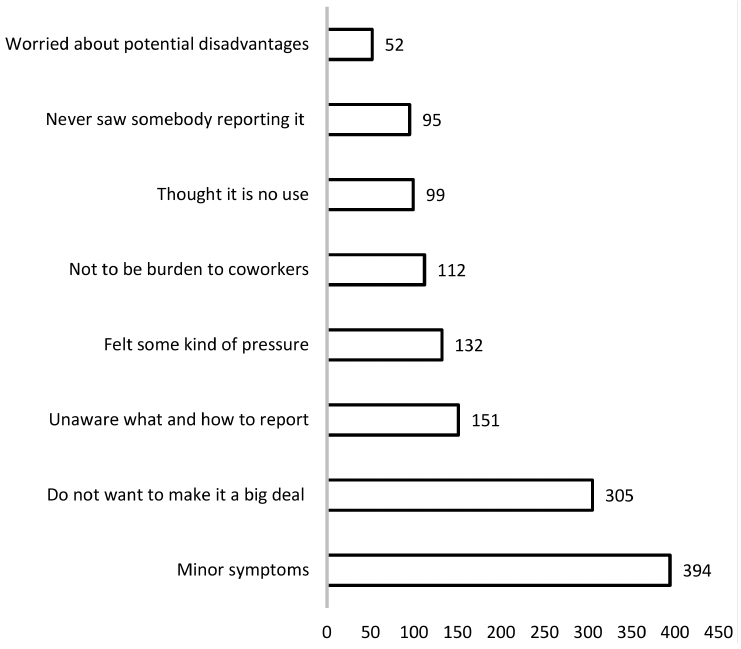
Figure 1. The reasons for not reporting WRMSD to the company (allowed multiple answers). Table 2. Frequency and prevalence (frequency/respondents) of musculoskeletal symptoms experi- enced during the past year ( n =